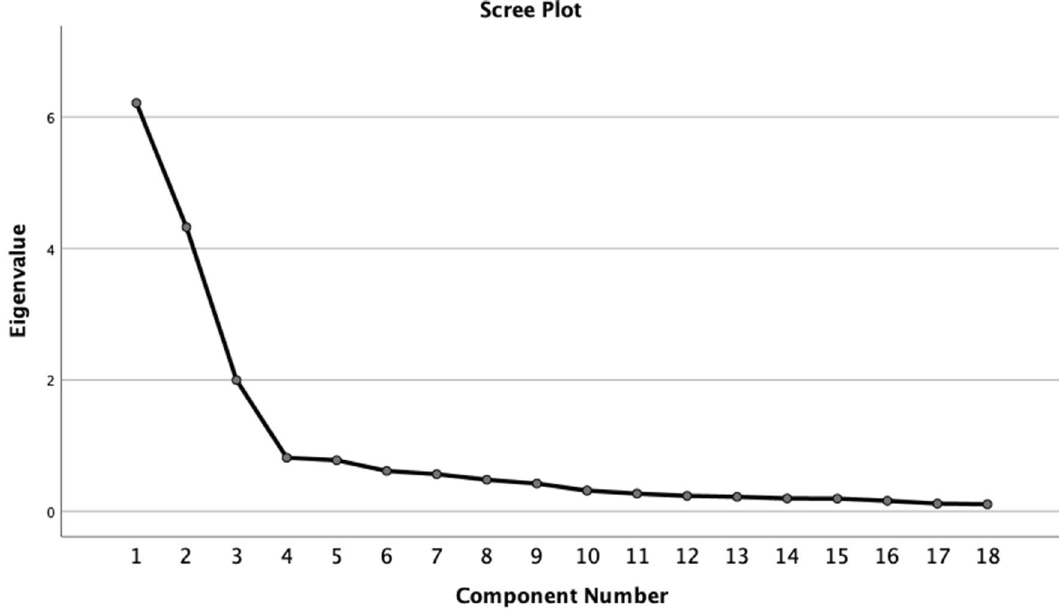
Figure 1. Scree plot of the exploratory factor analysis.